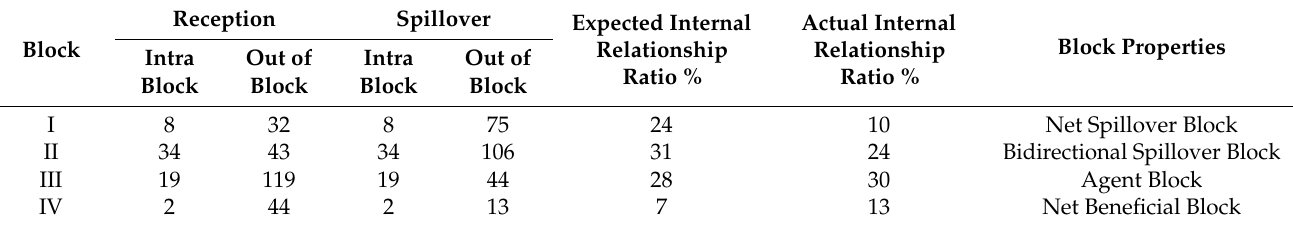
Table 5. Spillover effect of agricultural water use efficiency spatial correlation block in